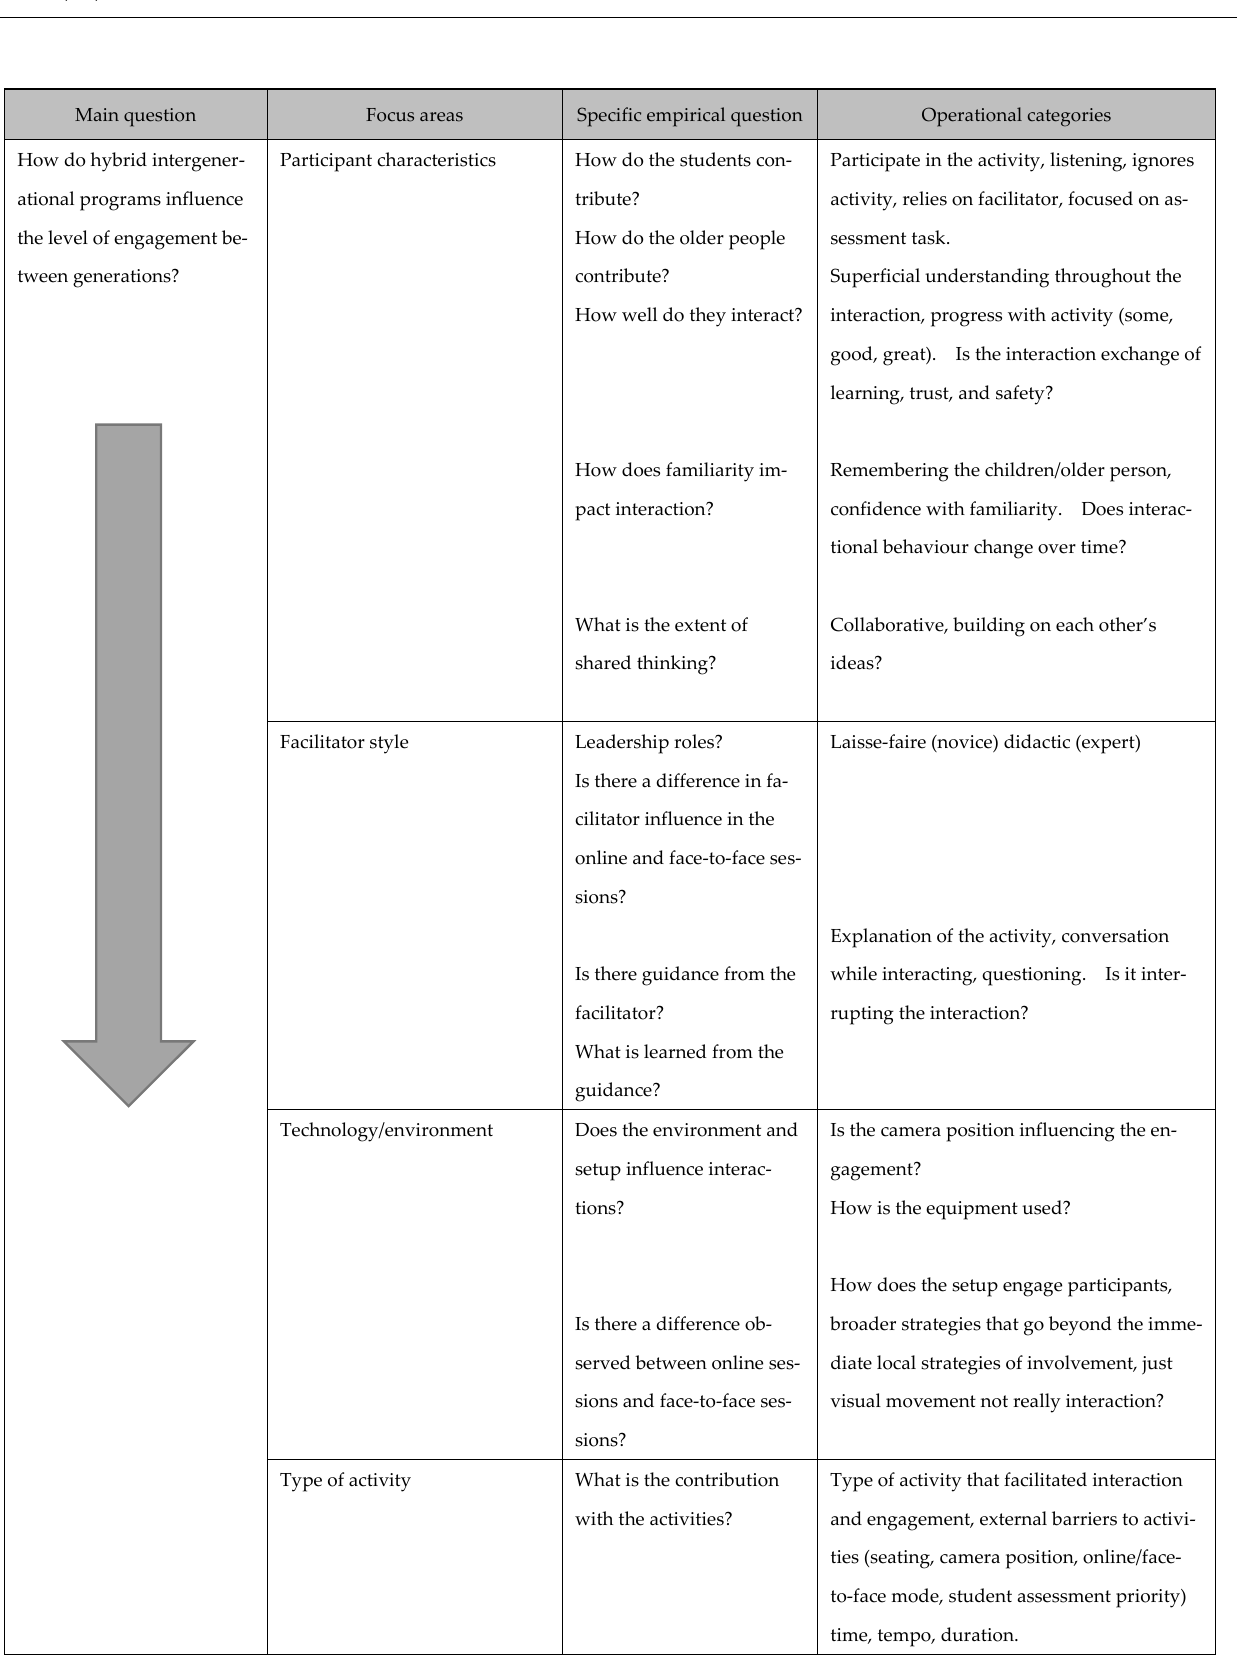
Figure 2. Guiding Components Framework. Adapted from Kirsnan et al. (2022).